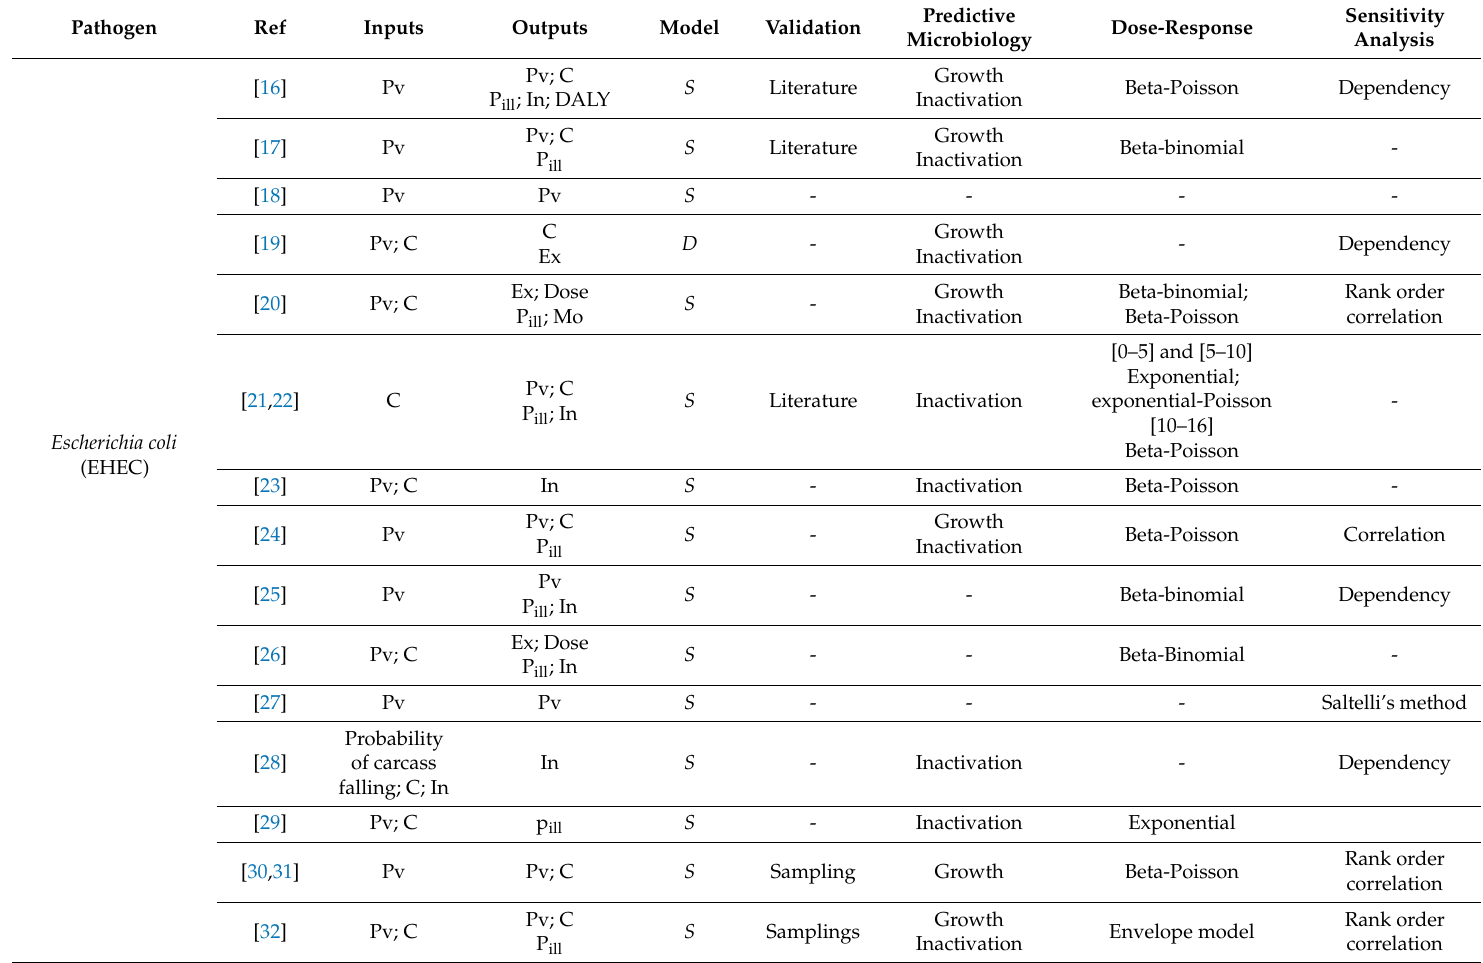
Table 2. Main inputs, outputs and methods observed among the collected QMRA models (Pv: prevalence; C: count and / or concentration; P ill : probability of illness; P out : probability of outbreak; In: incidence; DALY: disability-adjusted life years expectancy; Mo: mortality; S : stochastic model; D : deterministic